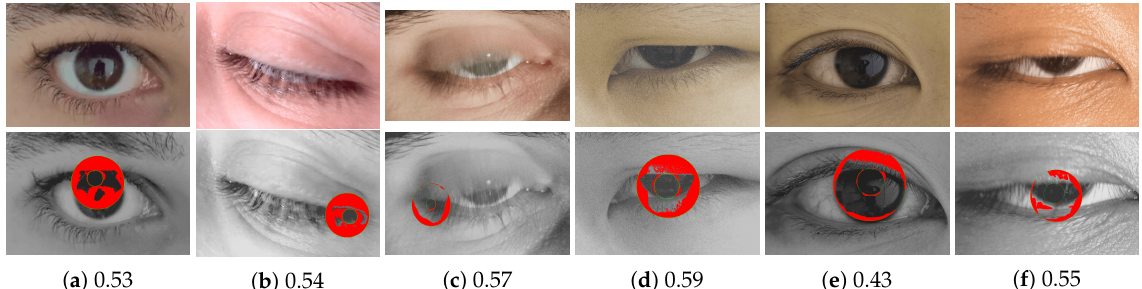
Figure 11. The first row shows some iris samples from the multi-modal biometric dataset GC 2 [36], which are classified by our DSMI metric as iris samples of sufficient quality if only one quarter of the iris images with the poorest quality are filtered out. Therefore, these images are passed to the iris recognition pipeline for further processing. However, all of these samples would be falsely rejected by the reference iris recognition system with high dissimilarity values (>0.47). The second row shows the segmentation result of the segmentation module of the reference iris recognition system. The DSMI scores are listed below the iris